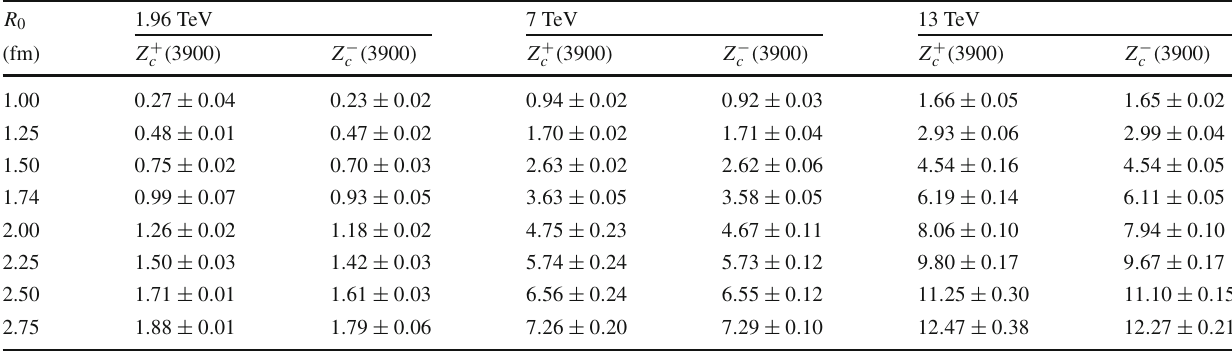
Table 3 The yields ( 10 − 6 ) of exotic resonant states Z + c ( 3900 ) and Z − c ( 3900 ) varies with parameter radius changing from 1 fm to 2.75 fm √ s = 1 . 96 , 7 and 13 TeV Z ± c ( 3900 ) states decaying in pp collision at